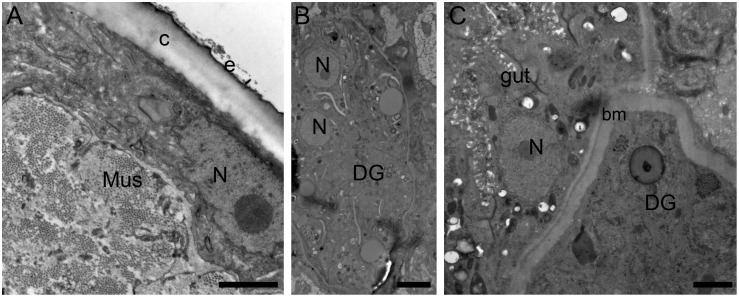
Microphotographs of O. volvulus (120 days in culture) show normal morphology of cells and developing organs.A, worms have a cuticle and epicuticle layer, also showed normal organization of muscle filaments (Mus). B, C, young adults have germ cells organized in developing gonads (DG) with basal membrane (bm). Abbreviation: N—nuclei. Bar A, C– 1 μm; B– 2 μm.